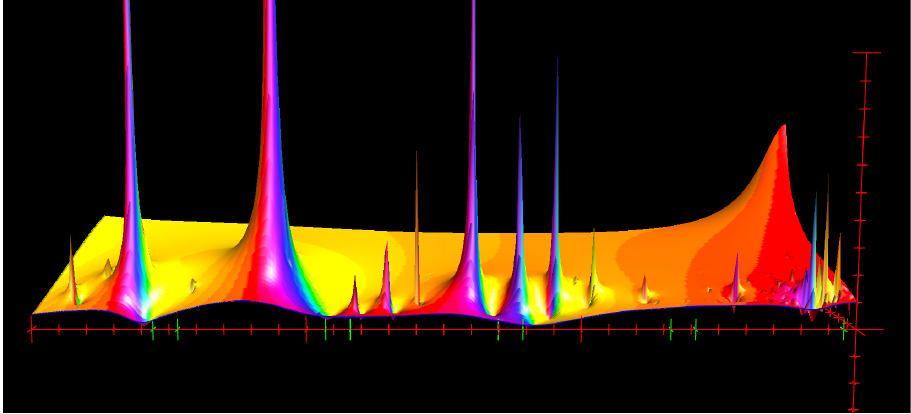
Figure 7. Response function amplitude of the outgoing wave at point R1 on the open boundary. Colours and scales as in Fig. 5.